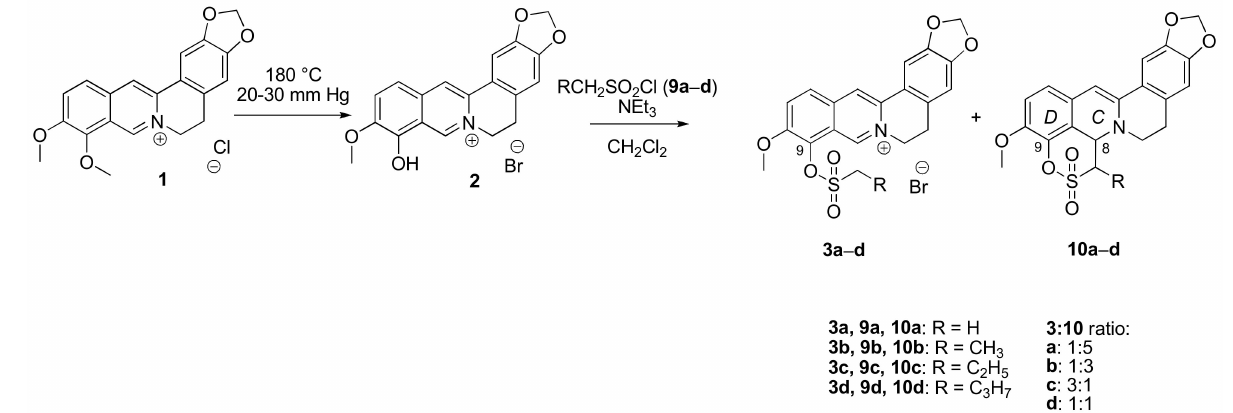
Scheme 1. Reaction of berberrubine 2 with alkylsulphochlorides 9a – d